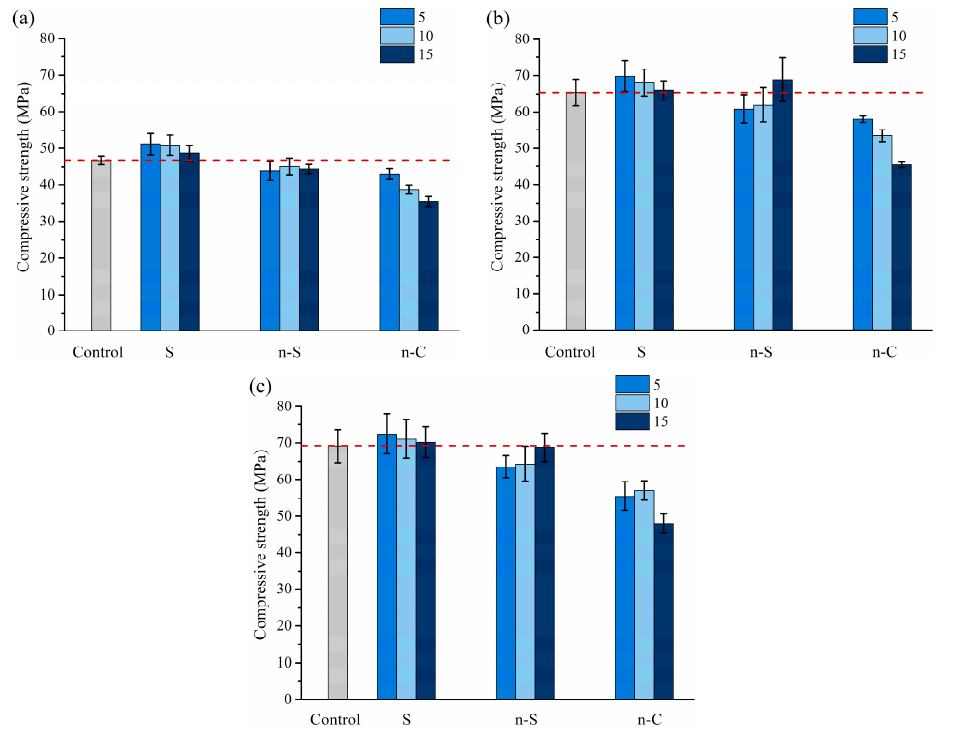
Figure 5. Effect of coating particles and thickness on the compressive strength: ( a ) 3 days; ( b ) 28 days; ( c ) 56 days.